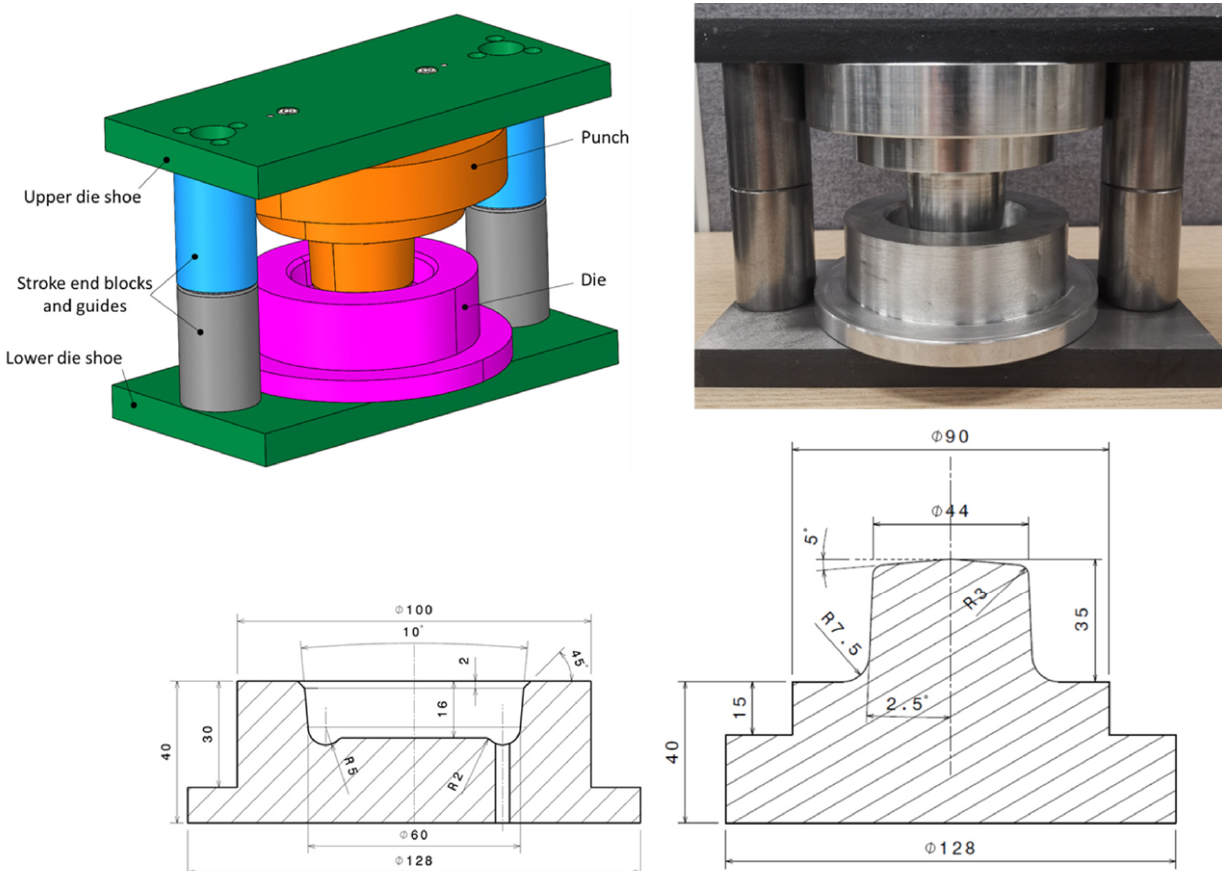
Figure 4. Scaled-up die set for plasticine analogue model of the clinching process (dimensions in mm).